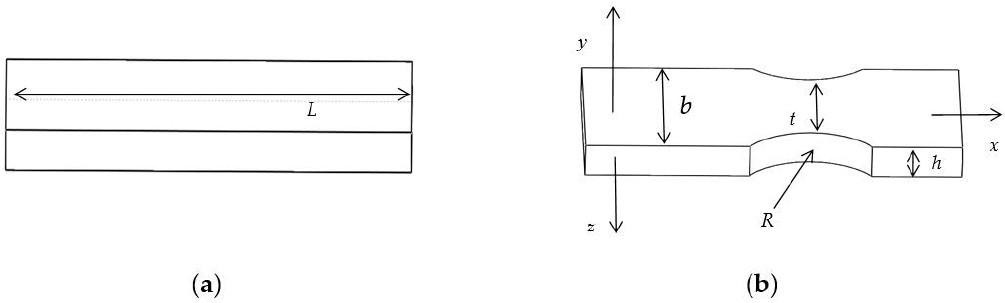
Figure 4. The structures of the elastic beams: ( a ) Traditional elastic beam; ( b ) new type of elastic